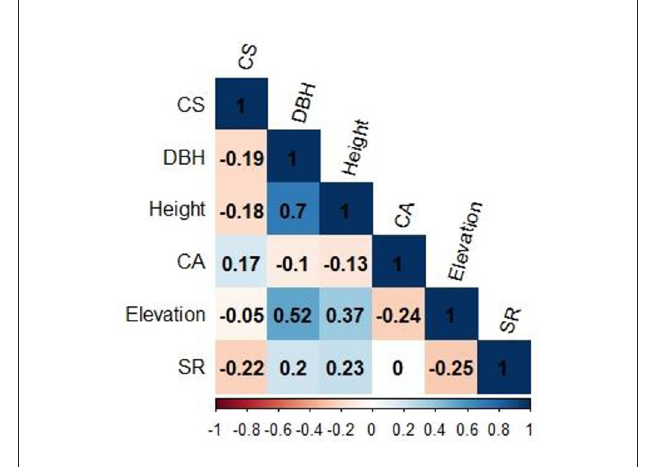
FIGURE4 Pearson correlation among all predictor variables. CS, Carbon sequestration; DBH, Diameter at breast height; CA, Crown area; SR, Species